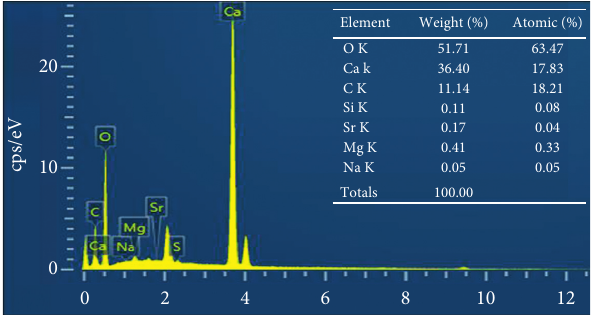
Figure 8: EDX spectrum of the eggshell after calcination